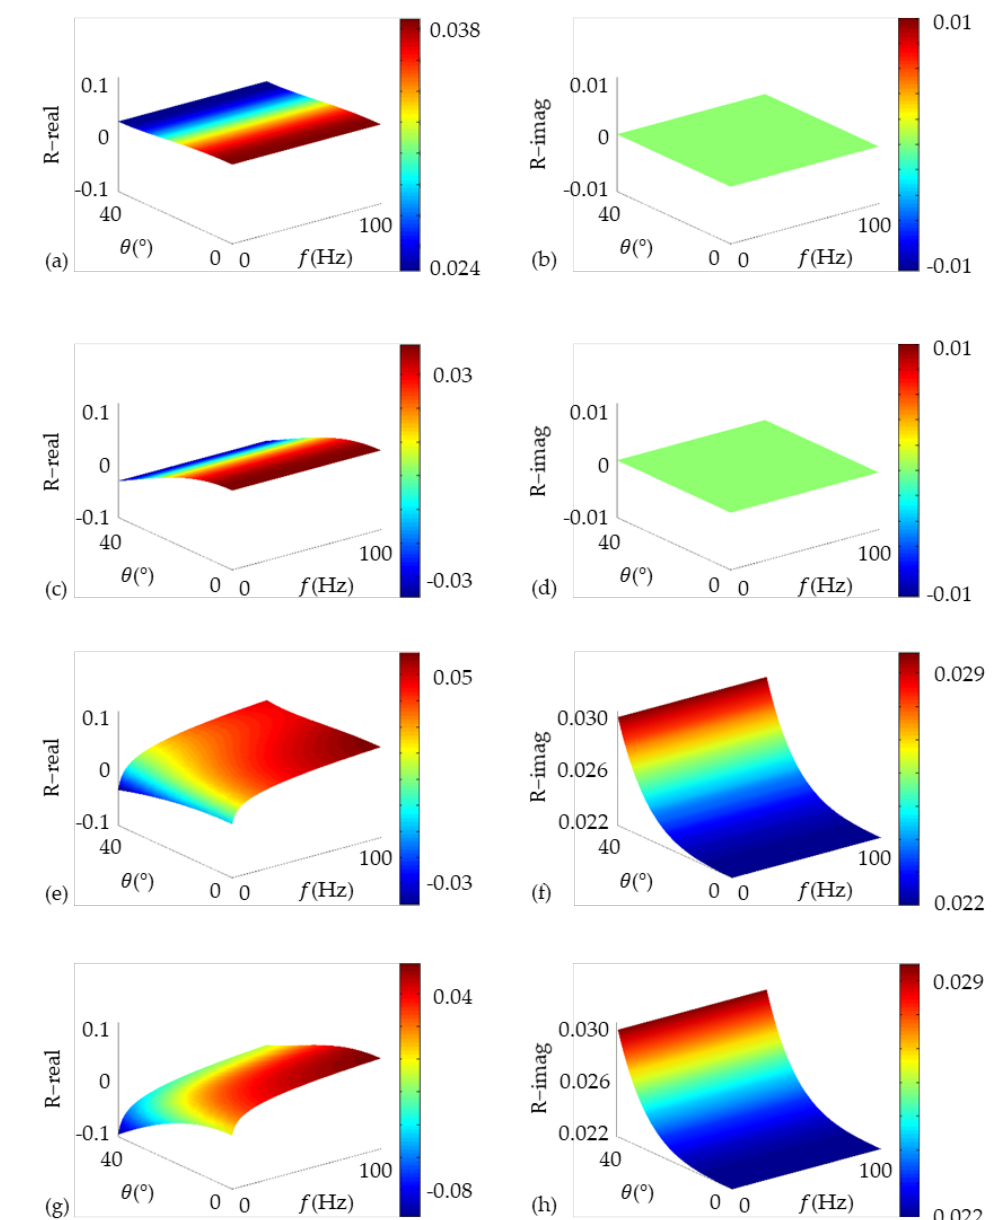
Figure 3. The variation of reflection coefficient with the incident angle θ and frequency f for model 2. ( a , b ), ( c , d ), ( e , f ) and ( g , h ) show the real part and imaginary part of reflection coefficients in four cases of assumption: (1) elastic isotropy, (2) elastic anisotropy, (3) attenuated isotropy, and (4) attenuated anisotropy separately. Different reflection coefficient values represent in corresponding colorbars. Table 1. The parameters of attenuated anisotropic model 1.